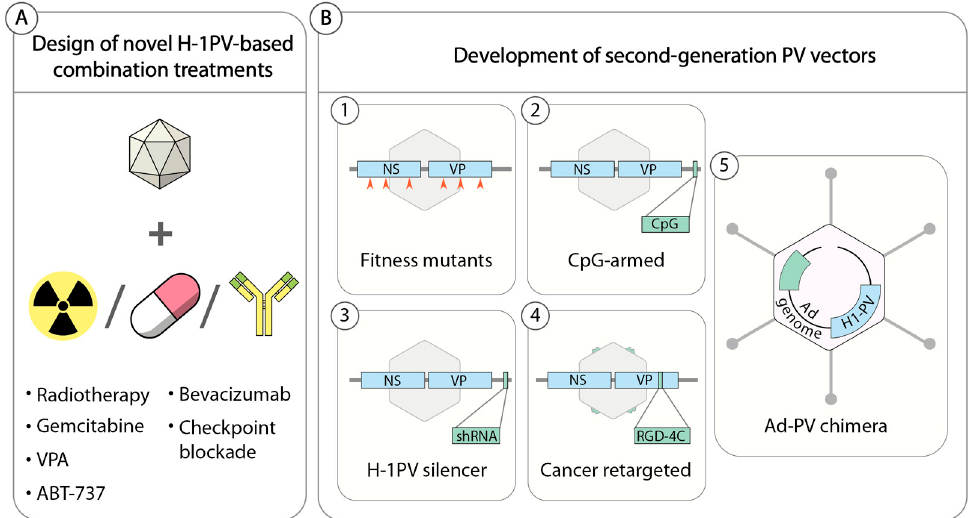
Figure 3. Improving H-1PV-based therapies. ( A ) Combination with drugs. H-1PV anticancer activity can be improved by combining the virus with other anticancer modalities. ( B ) Development of second-generation PV vectors. (1) H-1PV was successfully genetically modified by directed molecular evolution. By serially passaging H-1PV in semipermissive cancer cells, the virus acquired random mutations (orange arrowheads) that improved virus replication and spreading. (2 and 3) Functional elements (CpG motifs or an shRNA expression cassette) were inserted into the H-1PV genome without affecting its replication ability. These elements enhanced virus-mediated immune modulation and oncolysis, respectively. (4) Virus retargeting. The viral capsid was genetically modified by inserting an arginine-glycine-aspartic acid (RGD-4C) peptide, which improved cancer specificity at the level of virus cell entry. (5) Construction of Ad–PV chimeras. An engineered version of the H-1PV genome was inserted into a nonreplicative adenovirus (Ad) genome. The Ad–PV chimera brought the H-1PV genome into cancer cells and produced fully infectious H-1PV particles. The anticancer properties of Ad–PV chimera can be increased by inserting a therapeutic transgene into the Ad component of the Ad–PV hybrid genome (in green).